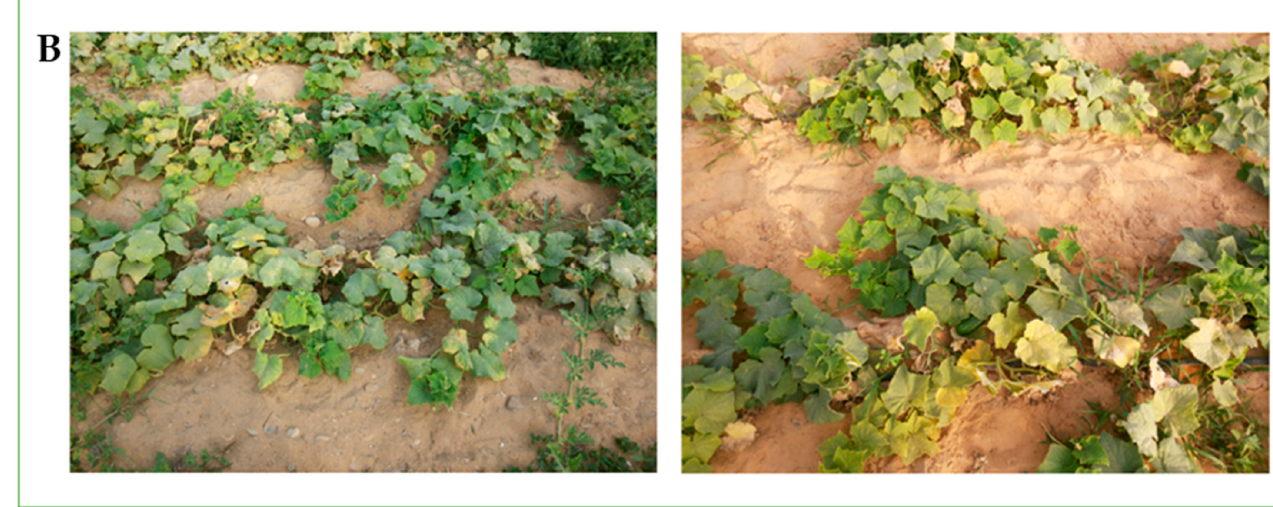
Figure 2. The effects of the incorporation of broccoli plantlets treatment on cucumber vegetative growth ( A ) and cucumber vegetative growth in control treatment ( B